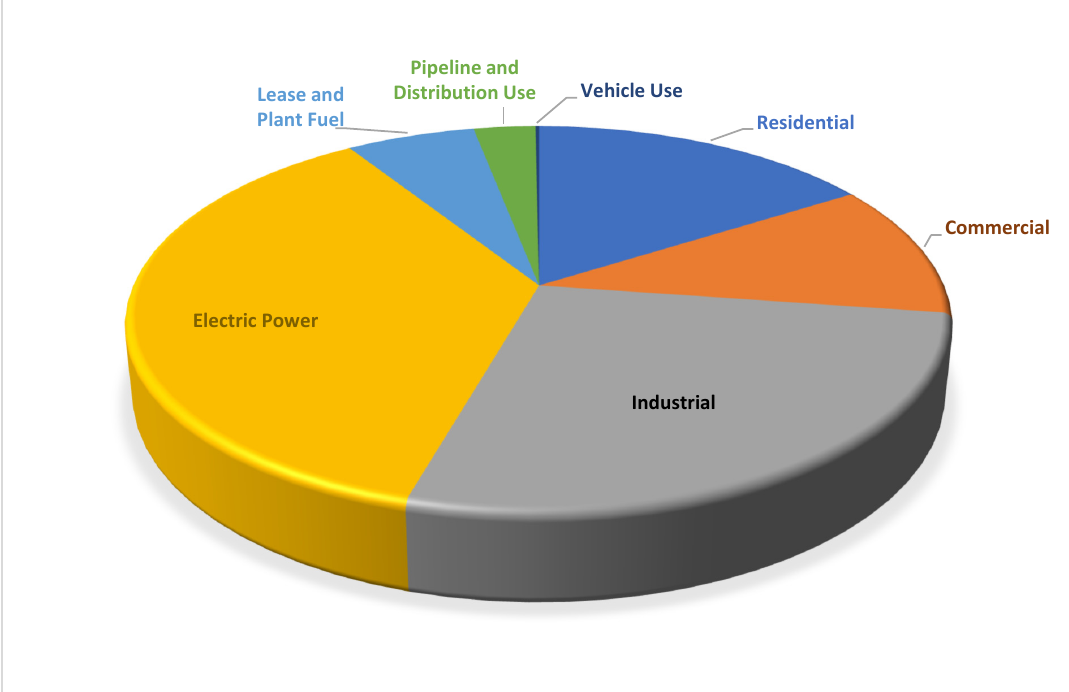
Figure 2. U.S. natural gas consumption by sector, 2019. Data source: U.S. Energy Information Administration.